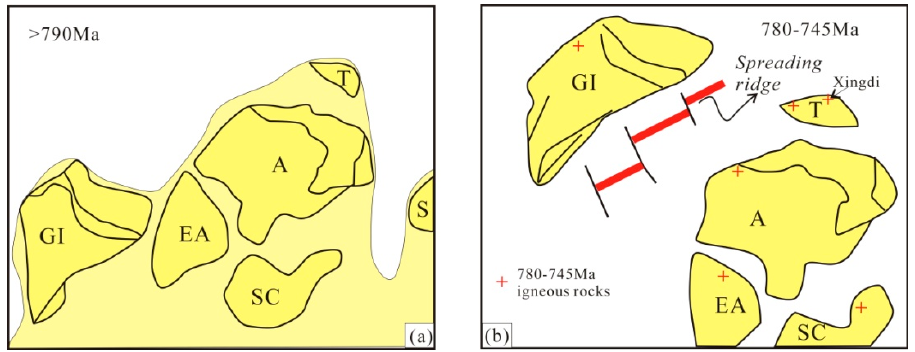
Figure 10. Tectonic model showing Tarim is adjacent to northwestern Australia during the early Neoproterozoic ( a ) and igneous activity (780–745 Ma) genetically related to the mantle plume during the breakup of the Rodinia supercontinent ( b ), the model is modified after [22,72]. A: Australia, EA: East Antarctica, GI: Great India, S: Siberia, SC: South China, T: Tarim.